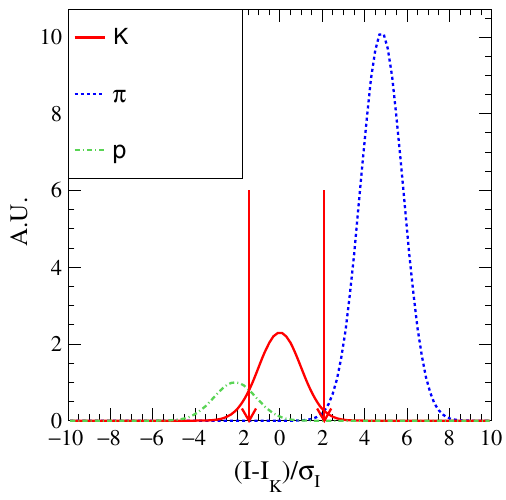
Fig. 5 Average separation power (cid:6) S (cid:7) versus momentum between dif- ferent particle types in hadronic decays at the Z pole. Left: only dE / dx is used. The bands delimit the area between the ideal simulation and the conservative scenario for the CEPC TPC. The optimistic scenario is